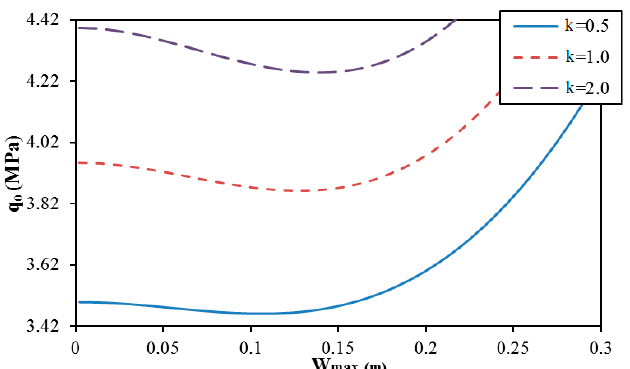
Figure 6. Effect of the volume fraction index k on the postbuckling curve of trapezoidal spiral corrugated sandwich FGM cylindrical shells ( K 1 = 10 7 N / m 3 , K 2 = 5 × 10 4 N / m, N = 1, e = 0.03 m, δ = π /3, and k = 1).